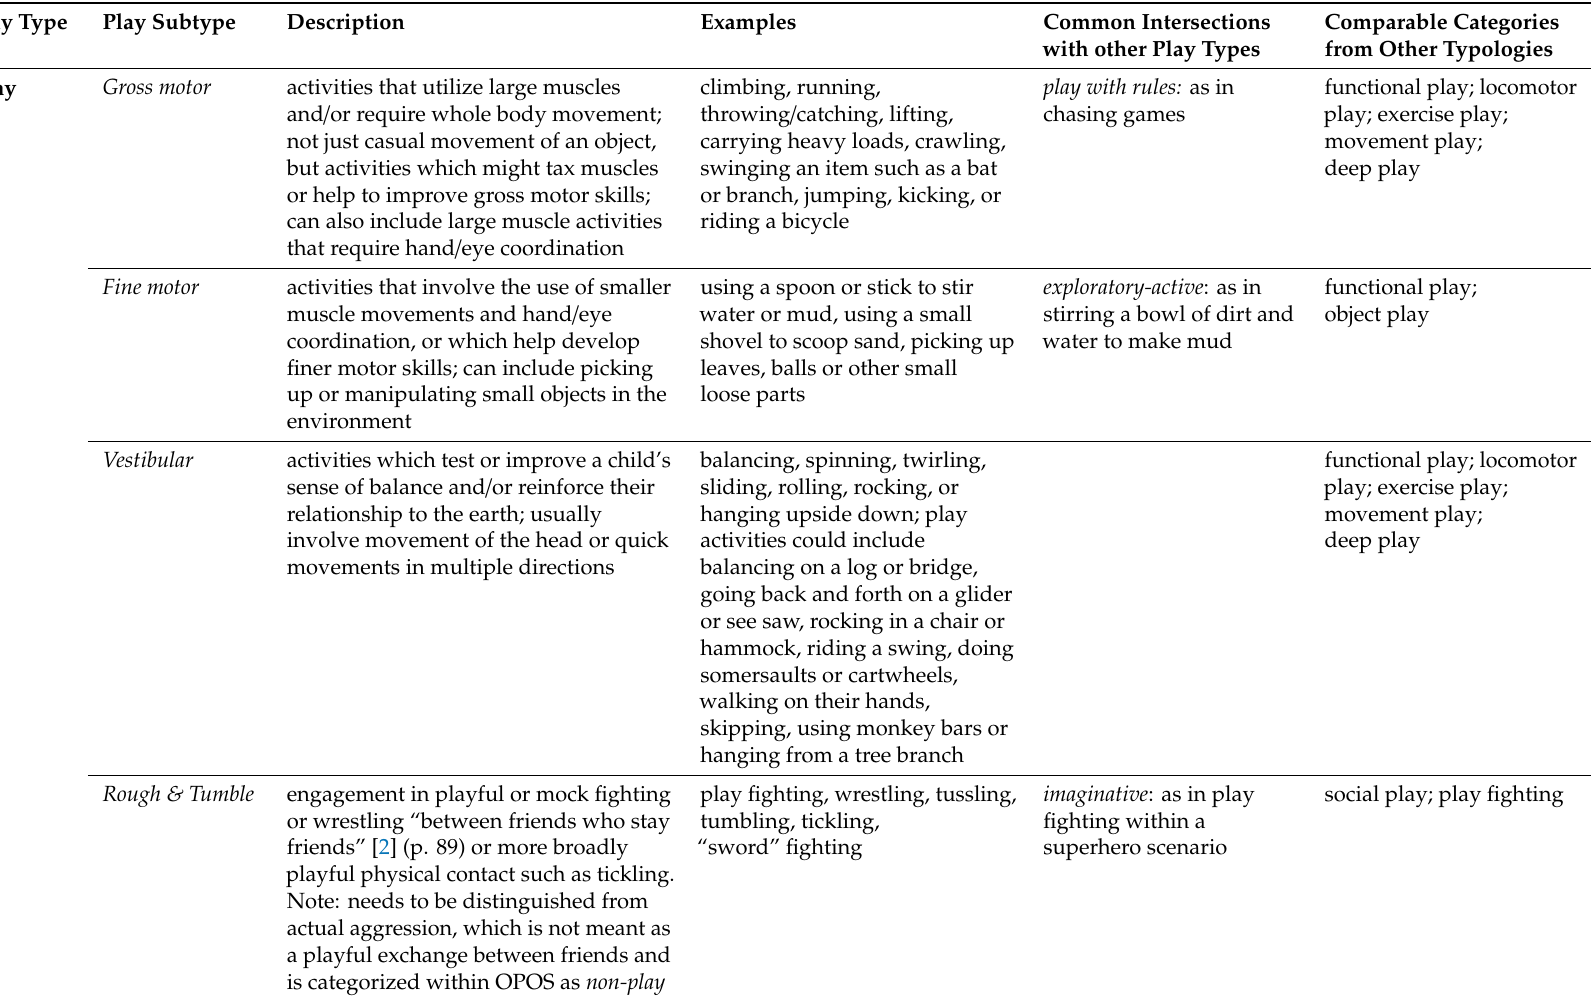
Table 4. TOPO outdoor play types